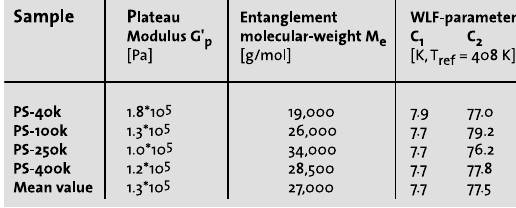
Table 1 (left): Investigated anionically polymerized polystyrene samples: num- ber-average molecular weight M n , weight-average molecular weight M w as measured by GPC and the thermodynamic glass tran- sition temperature T g . Table 2 (right): The entan- glement plateau modulus G’ p as obtained using the minimum of tan d in the master curves for the differ- ent polystyrene samples (see Tab.1). From these values the calculated entangle- ment molecular weight, M e , was calculated. The WLF- shift factors C 1 and C 2 were referenced to T = 408 K (= T g + 26 K, relative to